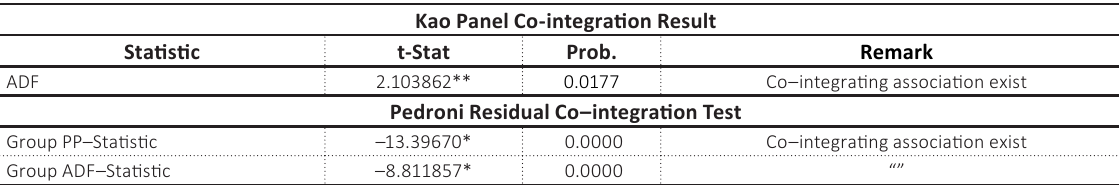
Table A5. Co-integration